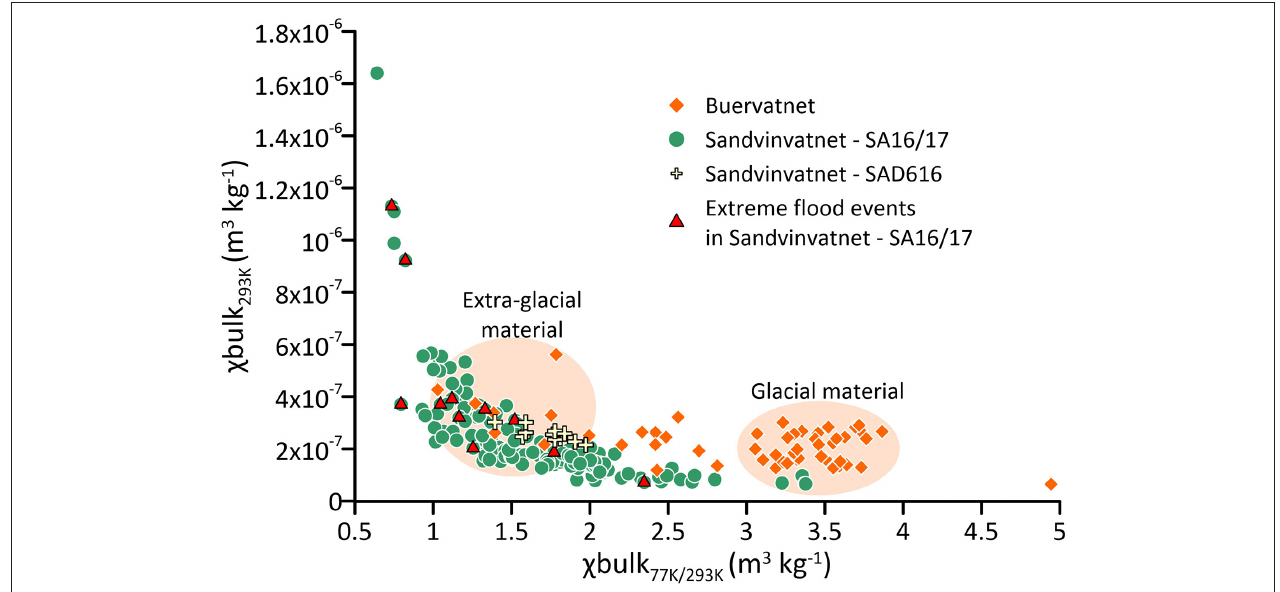
FIGURE 11 | χ bulk 293K and χ bulk 77K / 293K values from samples measured both on sediments from Lake Sandvinvatnet and Lake Buervatnet ( Figure 1 ). The shaded orange areas highlight the two main sedimentary classes in Buervatnet ( Røthe et al., 2019). These are organic material with ferromagnetic carriers ( χ bulk 77K / 293K from roughly 1–2.5), and glacial outburst floods (GLOFs) plus glacial material returning high χ bulk 77K / 293K values indicative of paramagnetic dominance. The χ bulk dataset from Sandvinvatnet (green dots/pale yellow crosses) and Buervatnet (orange squares) summarize a more complete view of sediment sources and magnetic properties of the Buerdalen